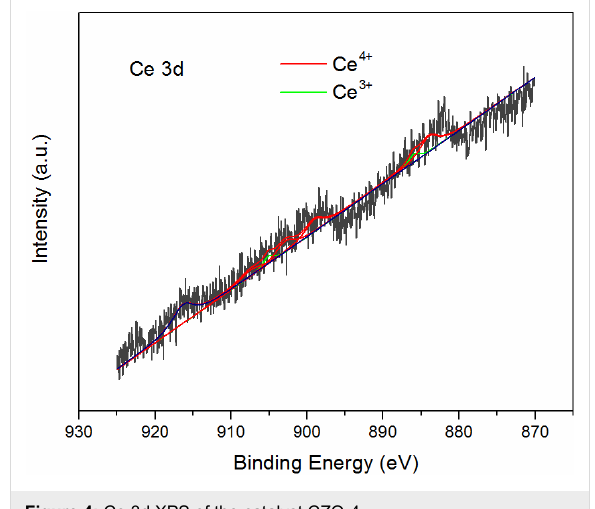
Figure 4: Ce 3d XPS of the catalyst